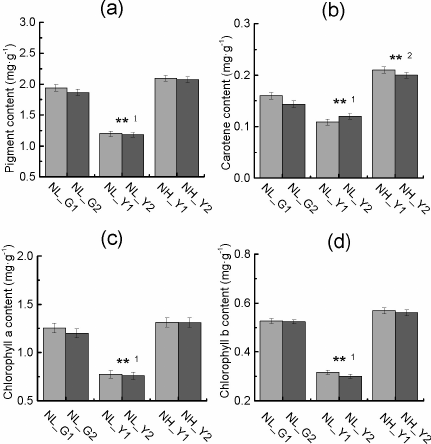
Figure 4. Differences in pigment content ( a ), carotene content ( b ), chlorophyll a ( c ), chlorophyll b ( d )